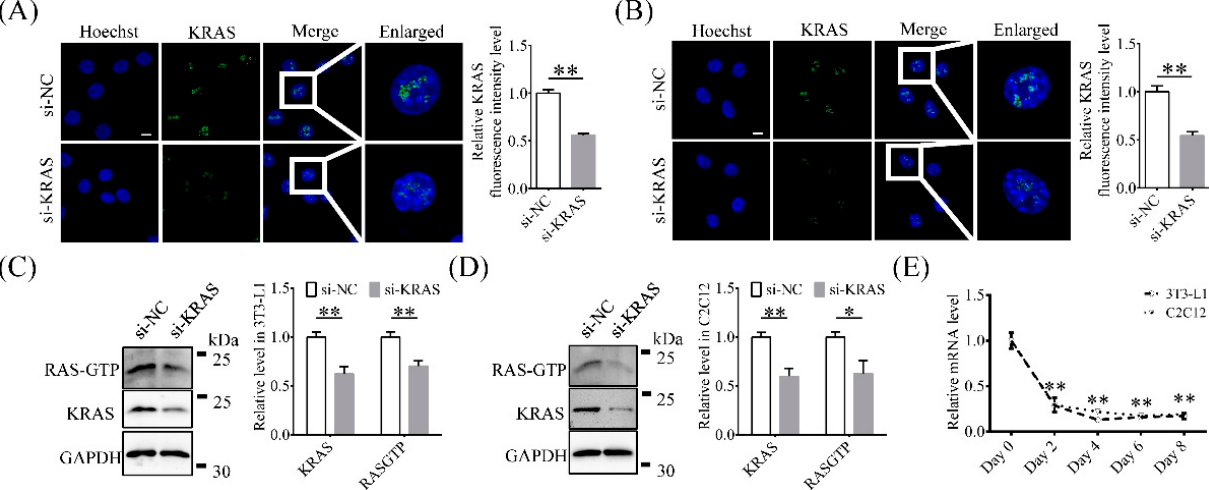
Figure 1. Intracellular localization of Kirsten rat sarcoma 2 viral oncogene homolog (KRAS) and knockdown efficiency determination. ( A , B ) Representative immunofluorescence images and relative fluorescence intensity levels of KRAS in 3T3-L1 and C2C12 cells with or without KRAS inhibition. Scale bar = 10 µ m. Significant differences are represented with ** ( p < 0.01). ( C , D ) Protein levels of KRAS and RAS-guanosine triphosphate (GTP) in 3T3-L1 and C2C12 cells with or without siRNA treatment. Significant differences are represented with * ( p < 0.05) and ** ( p < 0.01). ( E ) Relative Kras mRNA expression level changes during adipogenic differentiation in 3T3-L1 and C2C12 cells. Significant differences are represented with ** ( p < 0.01).